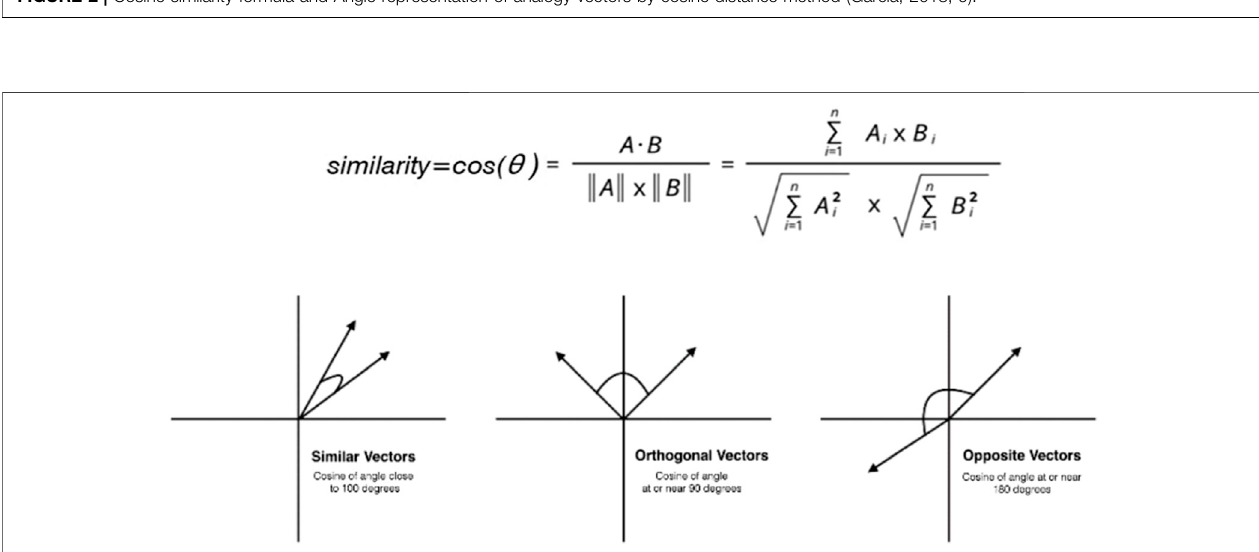
FIGURE 2 | Cosine similarity formula and Angle representation of analogy vectors by cosine distance method (Garcia, 2018, 9).